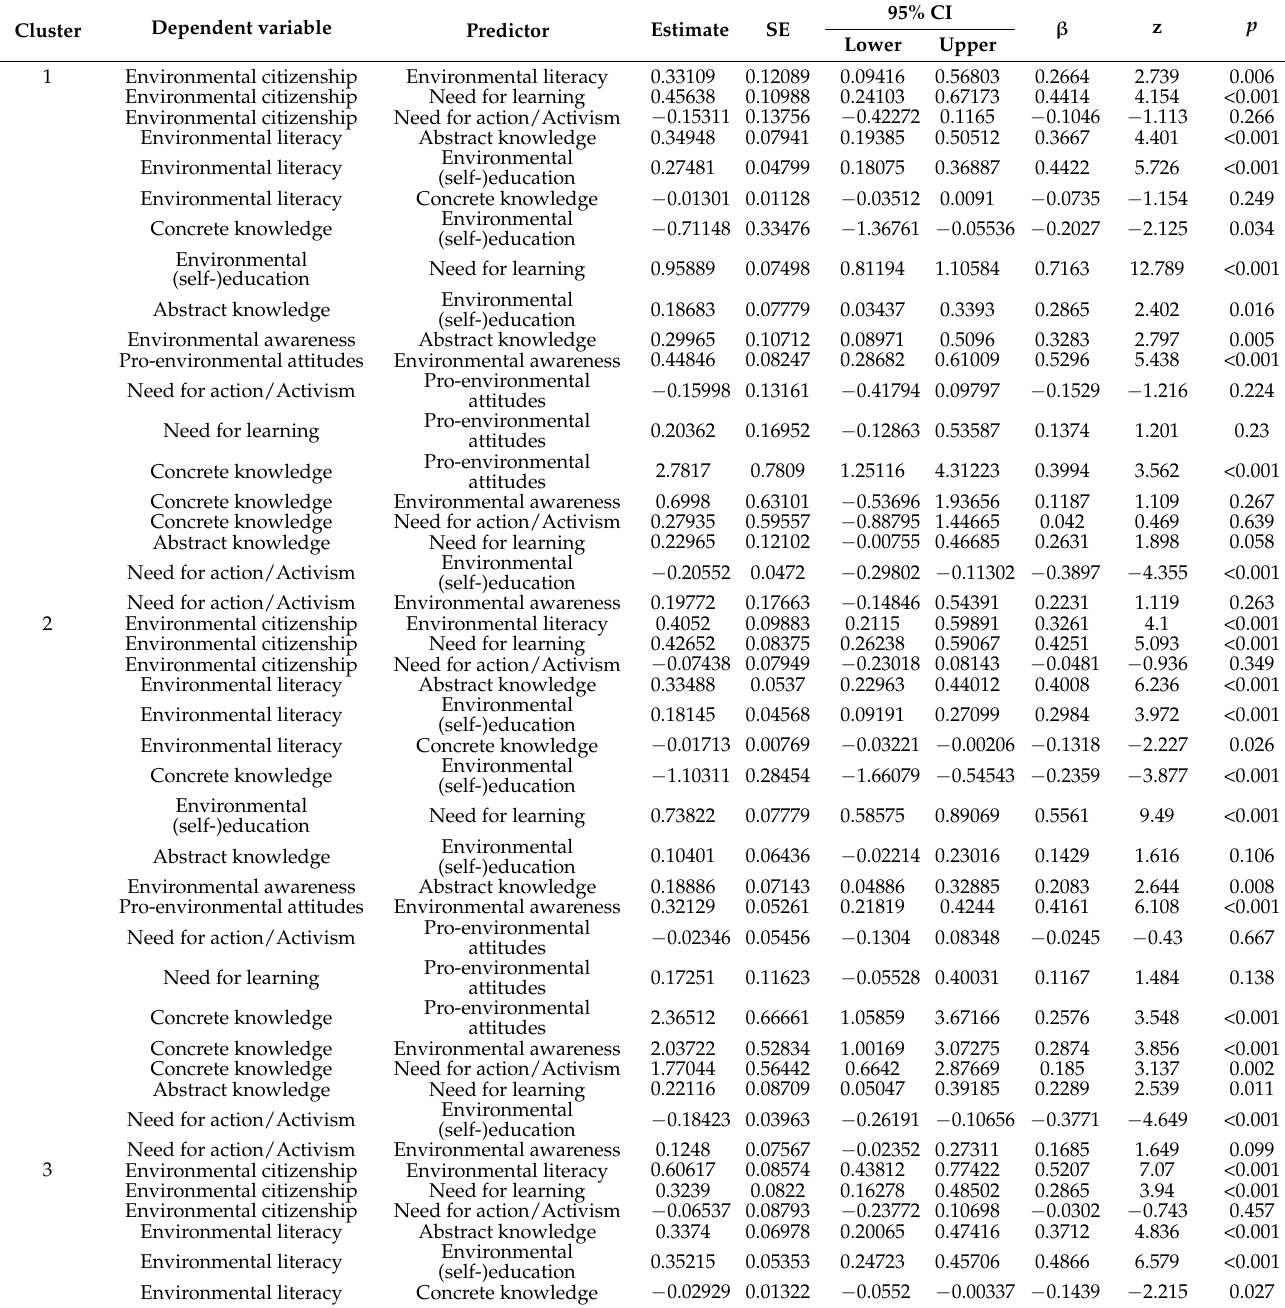
Table 3. Estimates of the multigroup structural equation, comparing the SMEC in